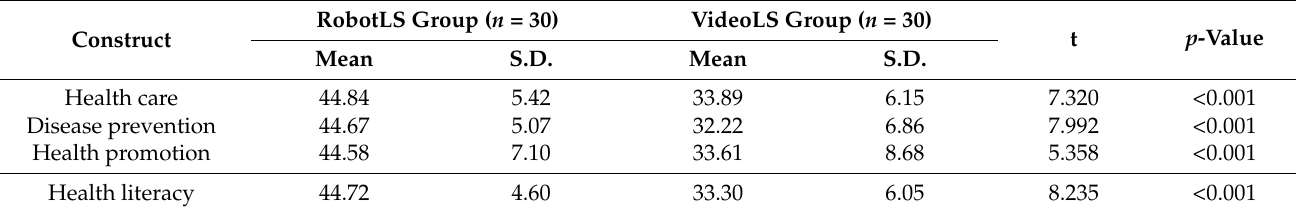
Table 5. Independent samples t-test on health